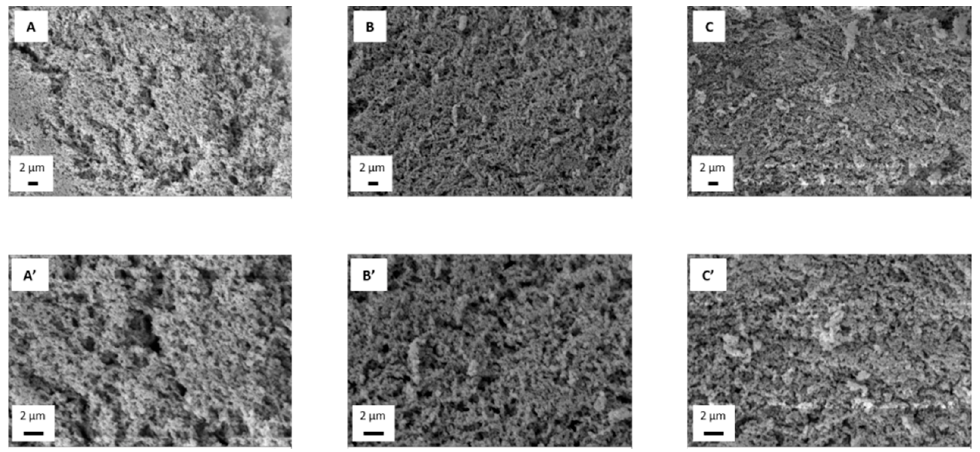
Figure 6. Microstructure of chitosan hydrogels with different biopolymer concentrations (1.0 ( A,A’ ), 1.5 ( B , B’ ) and 2.0 ( C , C’ ) wt.%) gelated at 4 °C. 1.5 ( B , B’ ) and 2.0 ( C , C’ ) wt.%) gelated at 4 ◦